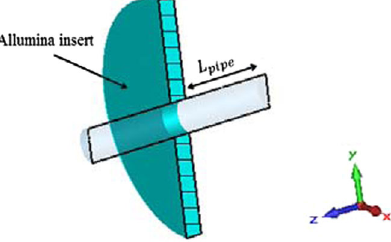
FIG. 15 (color online). CST model for the alumina insert: L ¼ 8 mm, t ¼ 30 cm, b ¼ 5 cm. The insert material is an